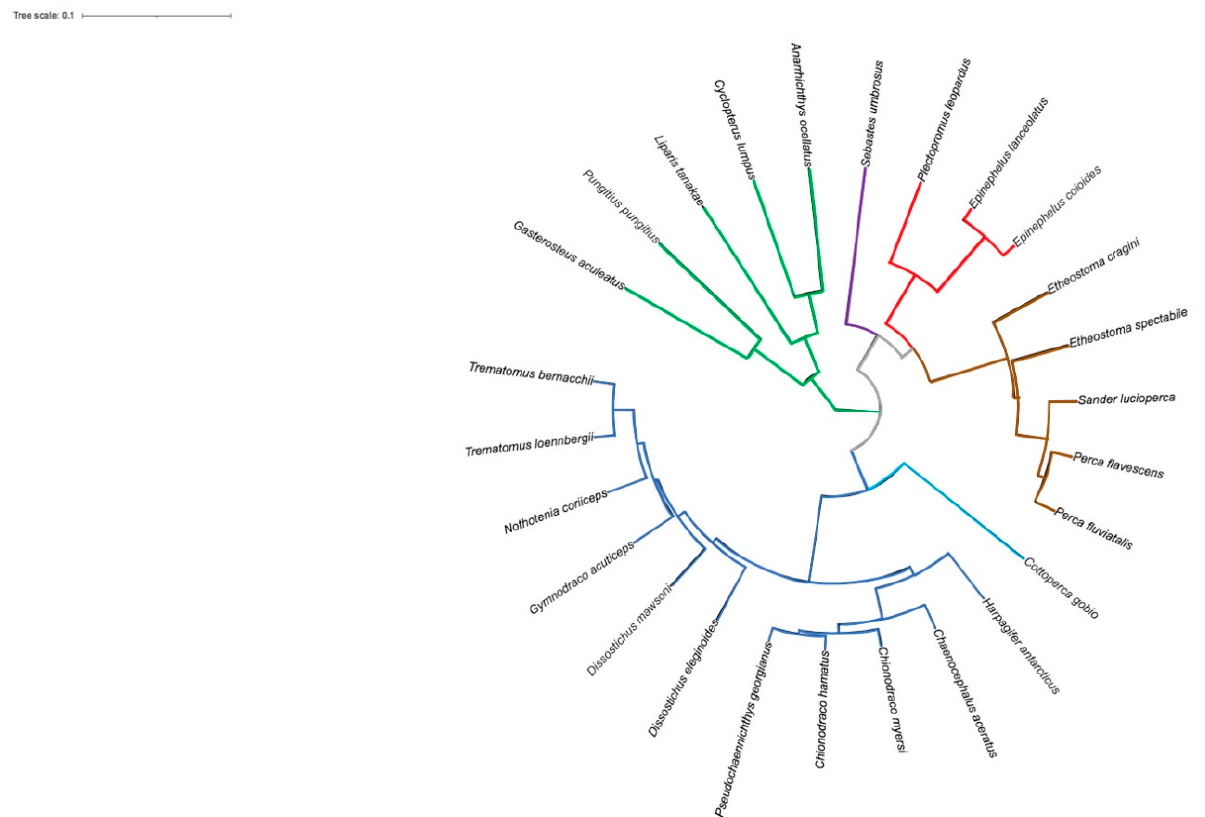
Figure 10. Distance tree of the pIgR D1 domain from teleost species belonging to the perciform suborders Notothenioidei (Antarctic species, blue lines; non-Antarctic species, light blue line), Percoidei (brown lines), Serranoidei (red lines), Scorpaenoidei (purple lines), and Cottoidei (green lines). The tree was generated by the Clustal Omega tool. The sequences used are in Figure 8.